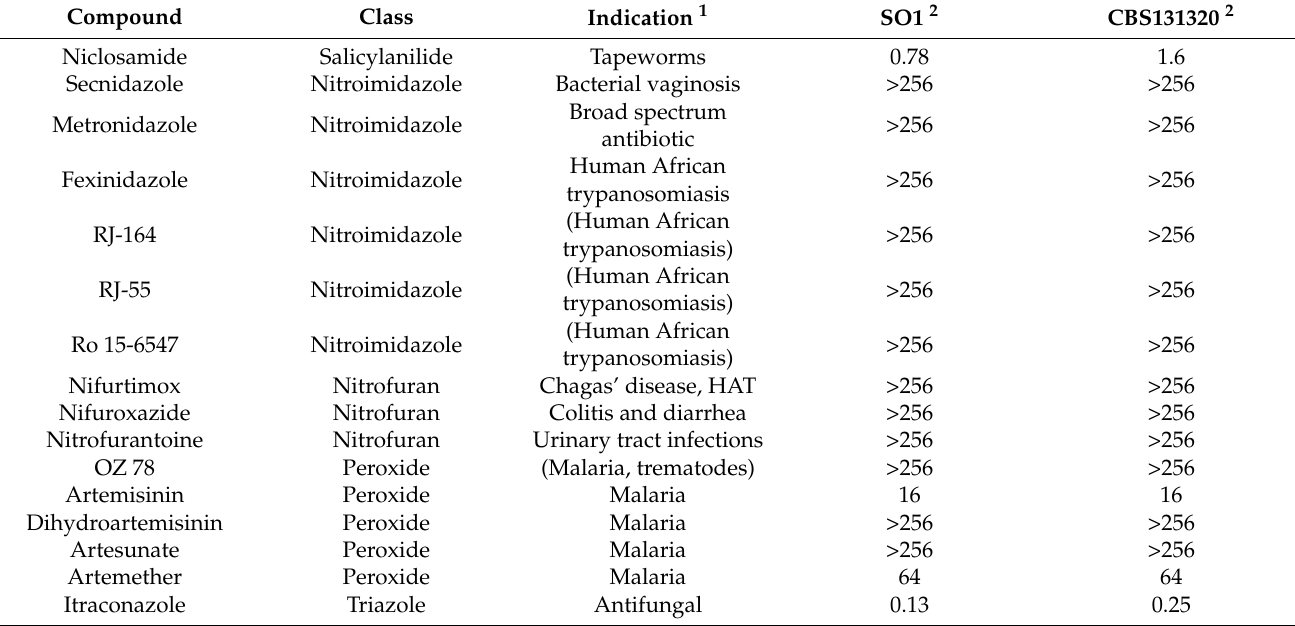
Table 1. Selected redox-active agents and their in vitro activity against M. mycetomatis : All assays were performed in triplicate. Values are minimal inhibitory concentrations (MIC) in µ